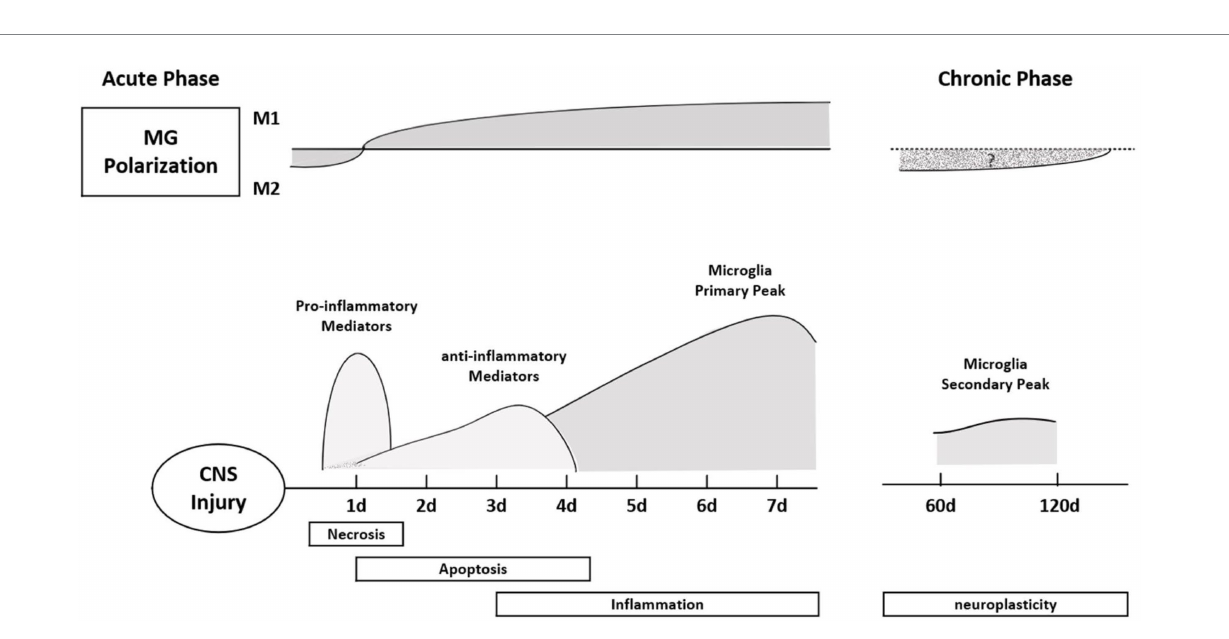
FIGURE 3 Polarization typing of microglia at different times after SCI. In the acute phase, microglia mainly express M1, showing a pro-inflammatory response. The pro-inflammatory effect of microglia reached a peak on the seventh day after the injury, and the inflammatory response became more obvious; in the chronic phase, the M1 type transformed into the M2 type, showing an anti-inflammatory effect. Finally, the second peak of microglia appeared during the neural remodeling phase (6–8 weeks after